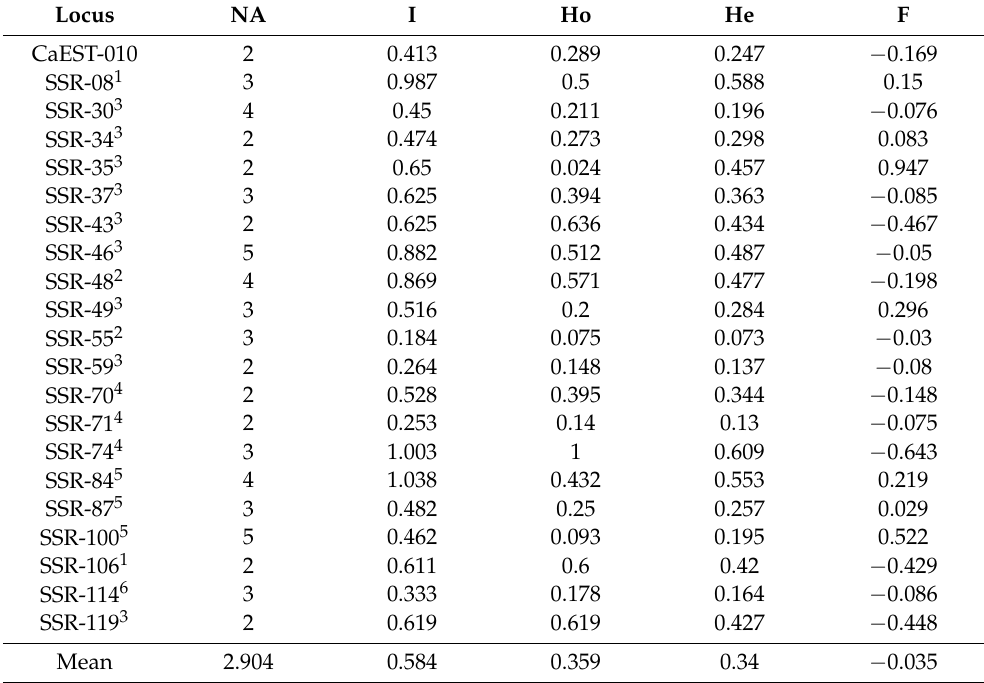
Table 1. Genetic parameters for the 20 SSR markers and 1 EST marker of the 44 analyzed geno- types. NA: number of alleles; I: information index; He: expected heterozygosity; Ho: observed heterozygosity; and F: fixation